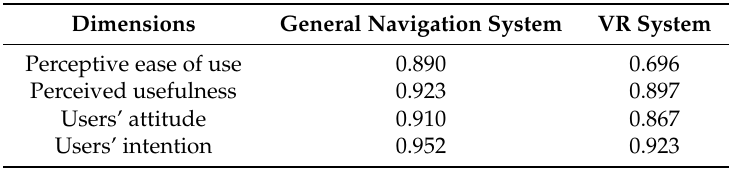
Table 1. Reliability analysis (Cronbach α ) of the questionnaire.